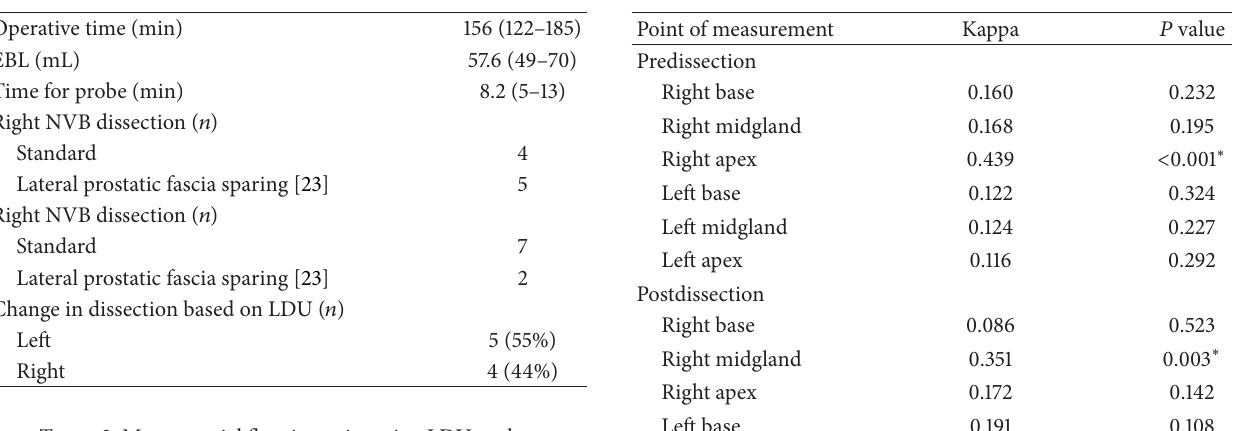
Table 3: Mean arterial flow intensity using LDU probe.